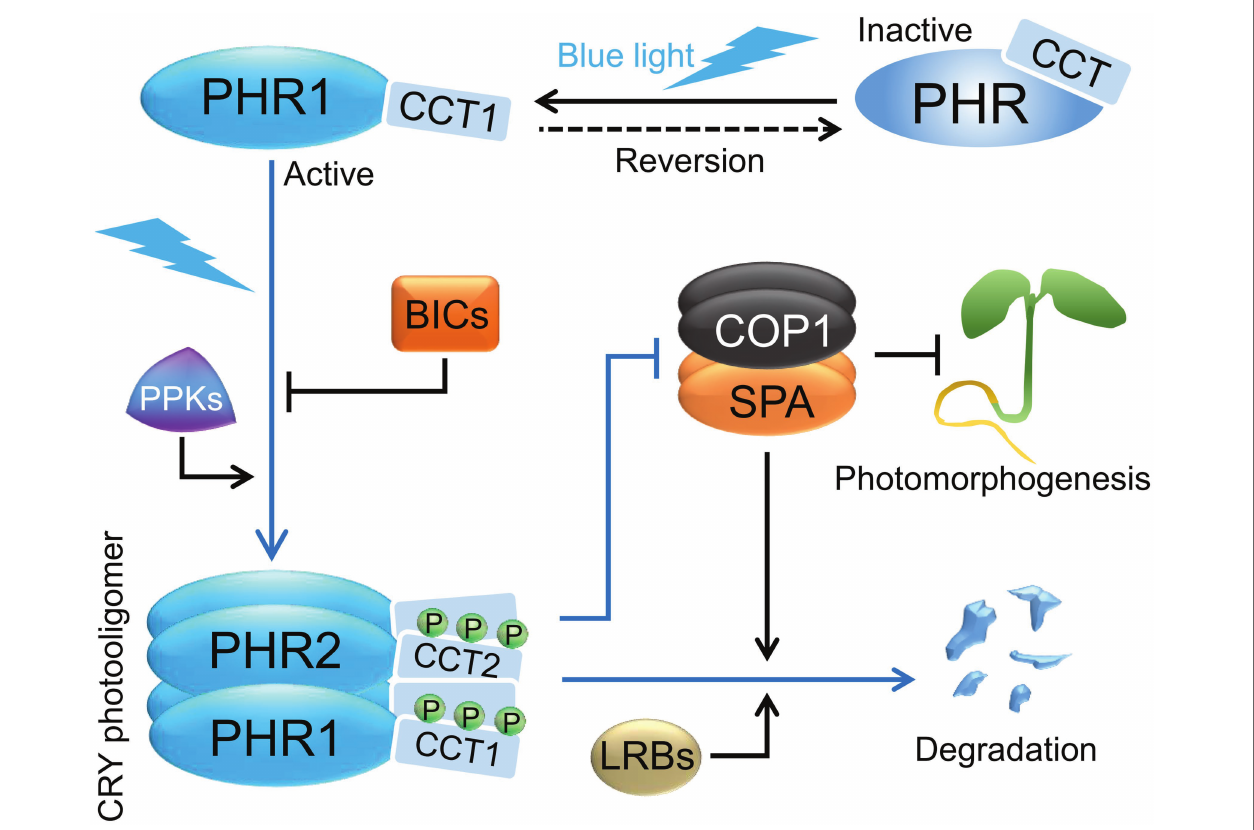
FIGURE 2 | Cryptochrome photoactivation and degradation. Cryptochromes exist as inactive monomers in darkness and are proposed to form a “closed” conformation with the C-terminal domains (CCTs) closely associated with the N-terminal domains (PHRs). In blue light, cryptochromes homo- and heterooligomerize via their PHR domains, and serine residues in the CCTs are phosphorylated by PPK kinases. In addition, the CCTs are proposed to dissociate from PHRs forming an “open” conformation. Photoactivated CRYs revert to inactive forms in darkness in a temperature-dependent manner, which may help in retaining their photoresponsiveness. In blue light, BICs suppress CRY photooligomerization and thereby affect CRY function. Exposure to blue light ultimately leads to the degradation of CRY2, and a lesser extent of CRY1, via the COP1/SPA and LRB ubiquitin ligases. CRYs promote photomorphogenesis in blue light via repressing COP1/SPA activity. Abbreviations: PHR, photolyase homology region; CCT, CRY carboxy terminus; BIC, BLUE LIGHT INHIBITOR OF CRYPTOCHROMES; PPK, PHOTOREGULATORY PROTEIN KINASE; COP1, CONSTITUTIVE PHOTOMORPHOGENIC 1; SPA, SUPPRESSOR OF PHYA-105 1; LRB, Light-Response